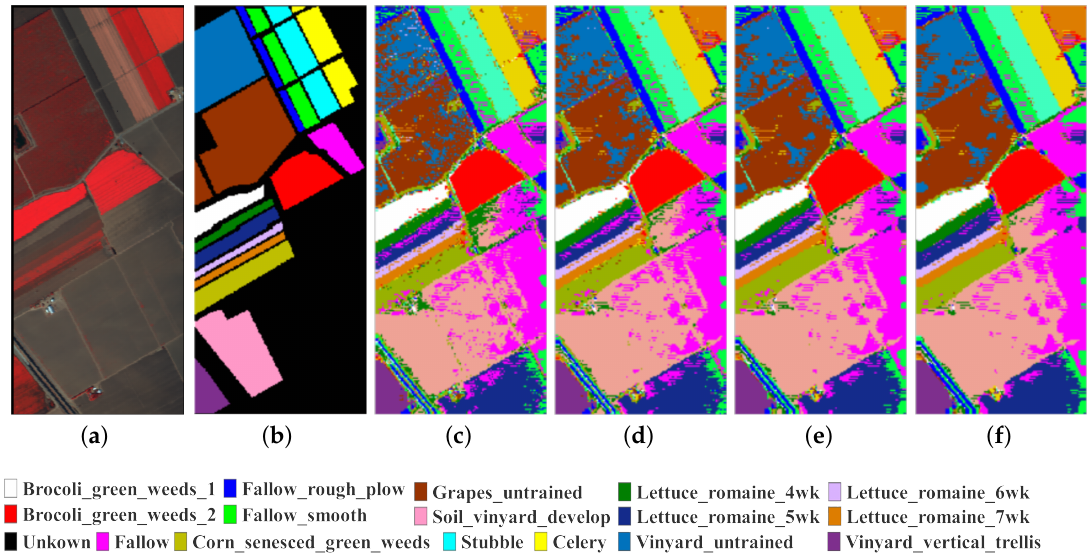
Figure 12. Thematic maps and OA (%) resulting from the ASSP-SCNN with different spatial window size on Salinas dataset with 16 classes. ( a ) Pseudocolor image. ( b ) Ground-truth map. ( c – f ) Classification maps with w × w to be 5 × 5, 7 × 7, 9 × 9 and 11 × 11,